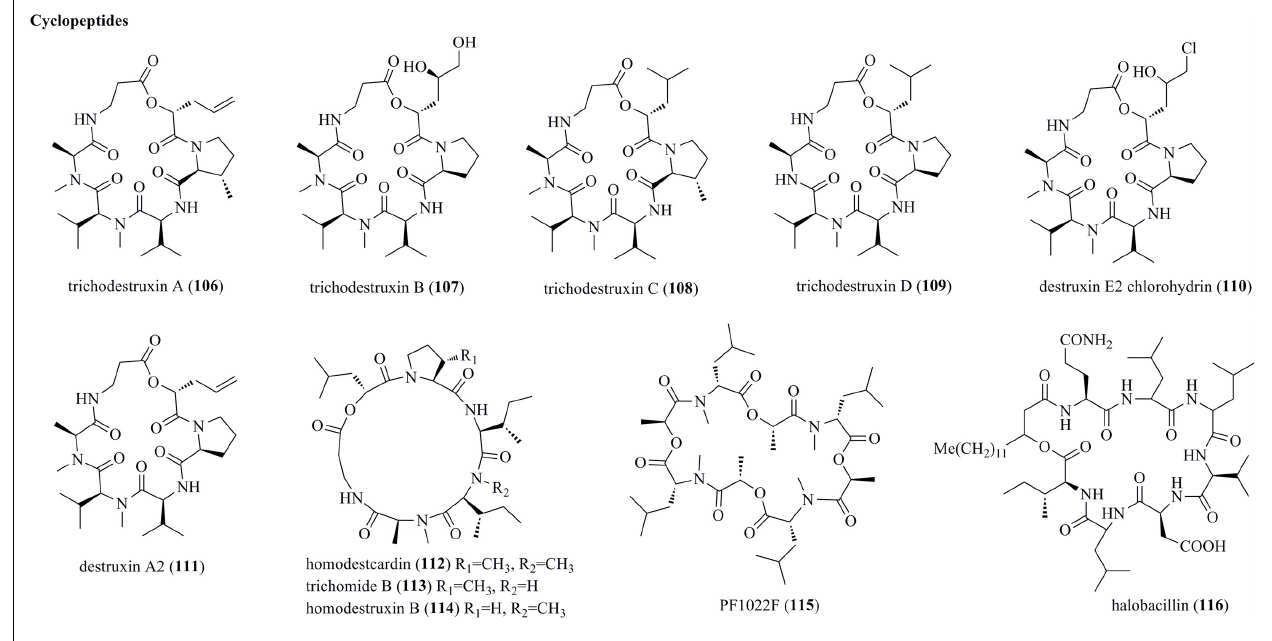
FIGURE 5 | Cyclopeptides produced by Trichoderma species ( 106–116 ).